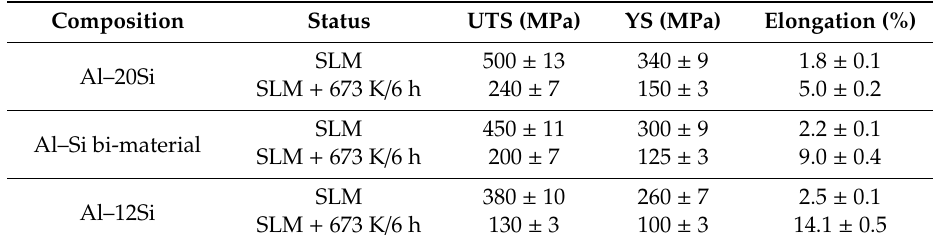
Table 1. Mechanical properties of Al–Si alloys and the Al–Si bi-material. UTS = ultimate tensile strength; YS = yield strength.